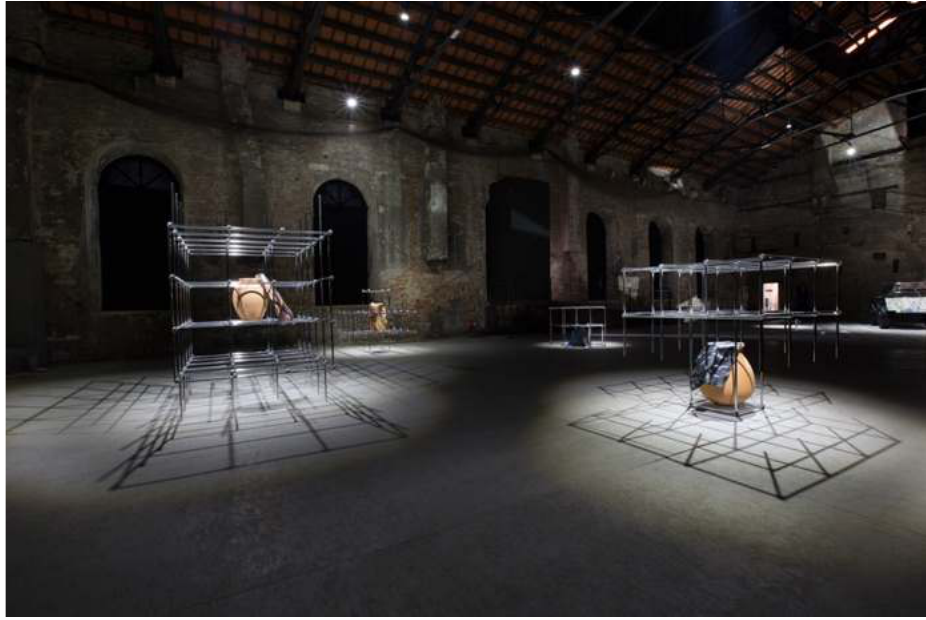
Photo by Vinciane Lebrun-Verguethen ALFT: Prior to the opening of the Biennial, an article published on March 27, 2017 in Artnews online 2 announced that the HyperPavilion would present “post-humanist art”. How would you de fi ne